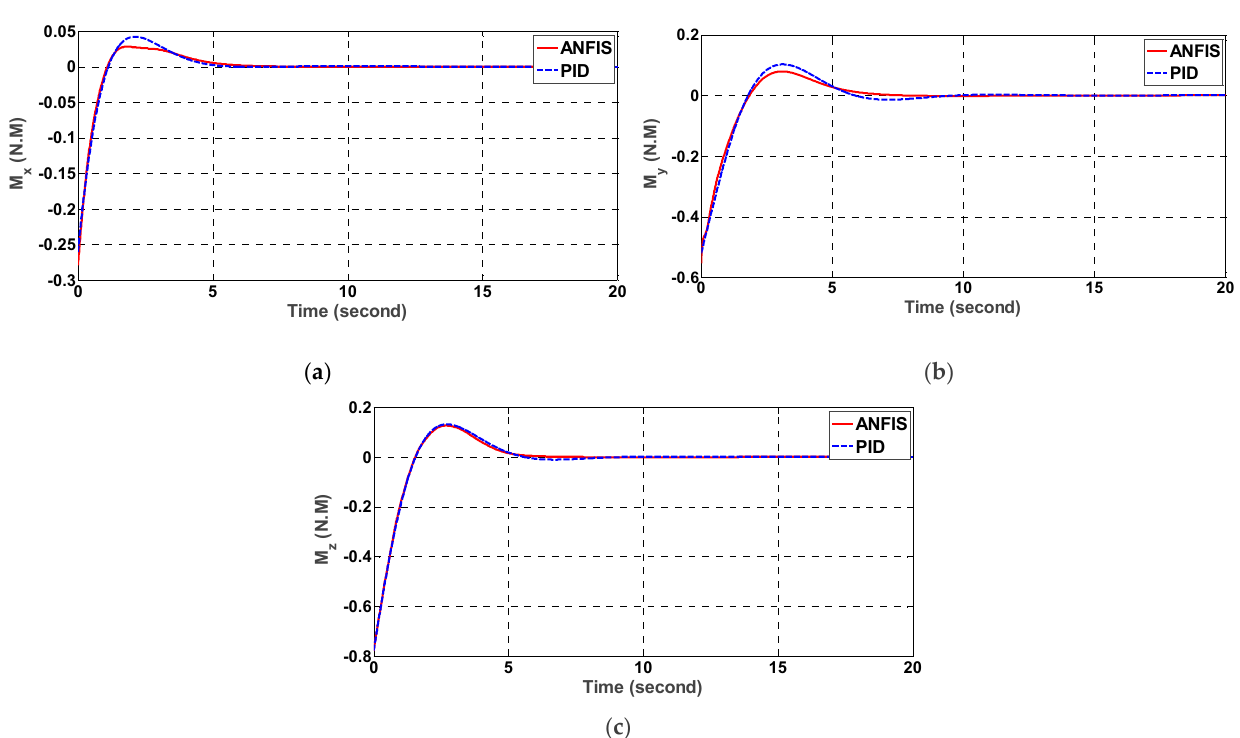
Figure 8. Comparison of control moment in ( a ) X, ( b ) Y, and ( c ) Z directions using ANFIS and PID in the presence of